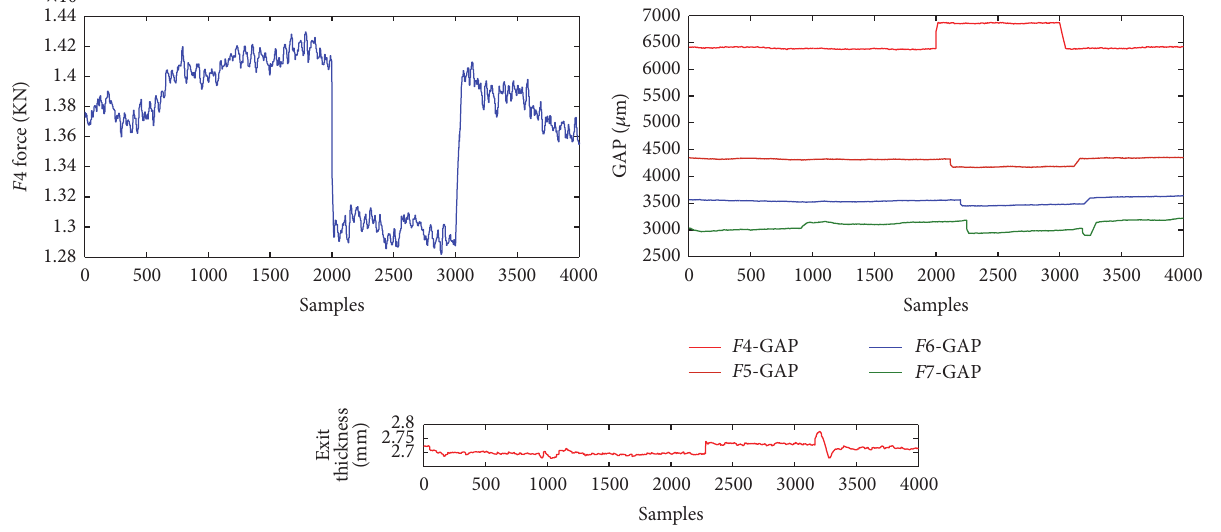
Figure 5: Curve of fault source x 4 and affected